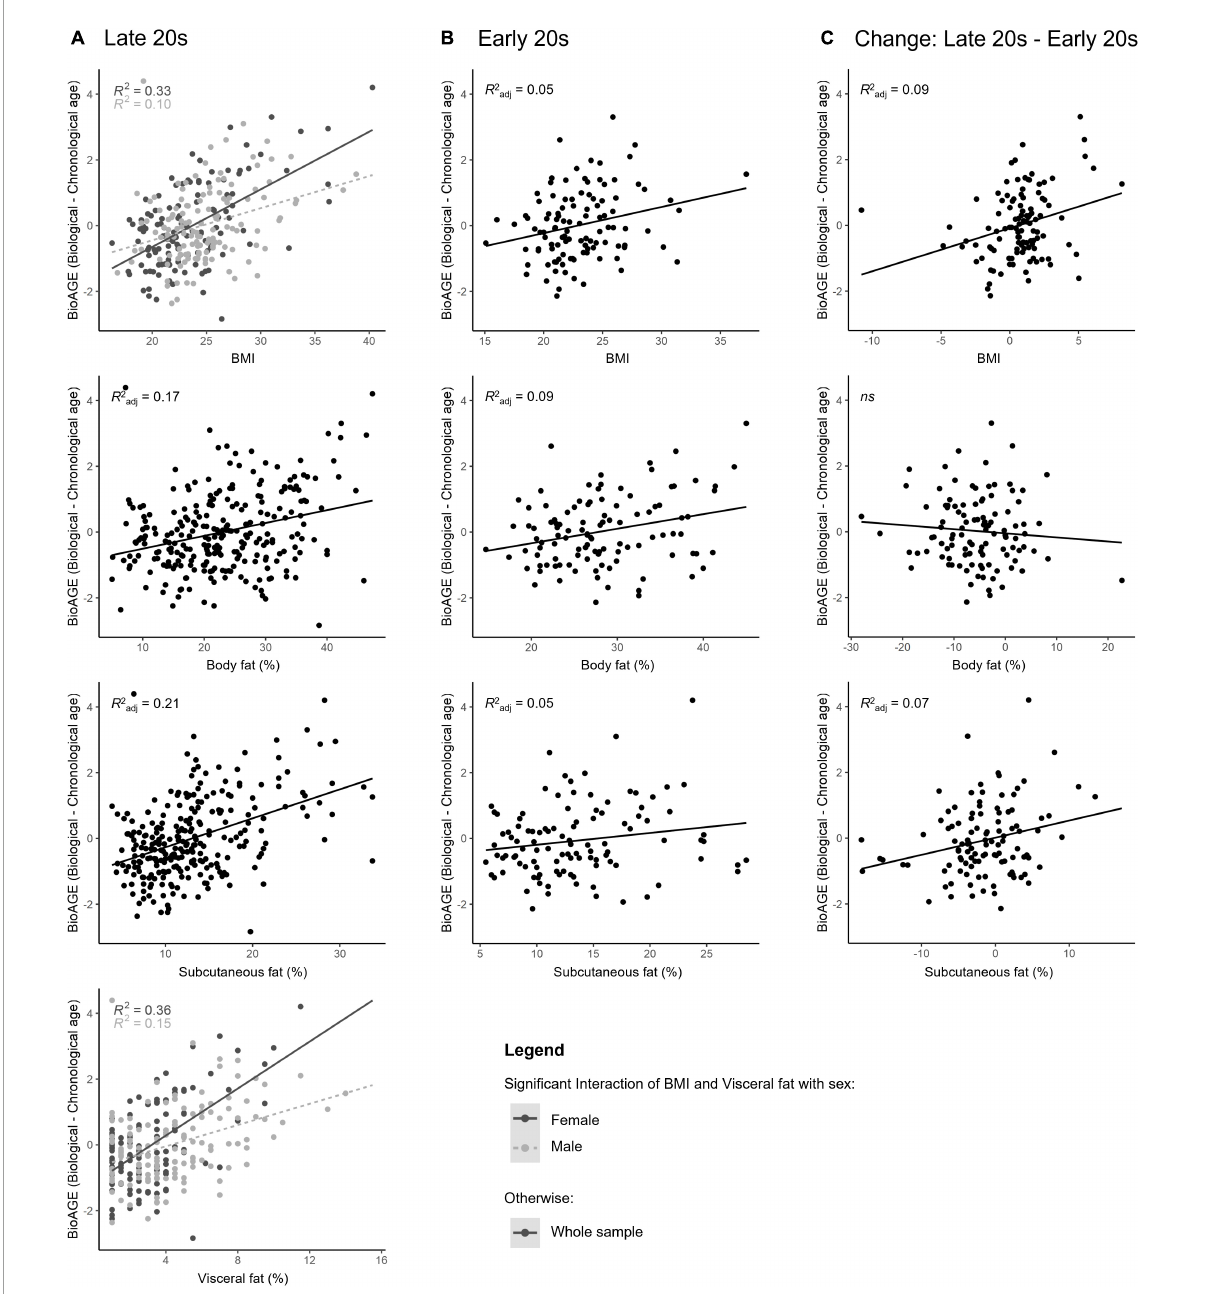
FIGURE2 BMI and body fat in young adulthood as predictors of biological aging. Accelerated biological aging in the late 20s was predicted not only by BMI and body fat measured in the late 20s (A) , but also by BMI and body fat in the early 20s (B) , as well as the change in BMI and body fat over the 5-year period between the measurements (C)